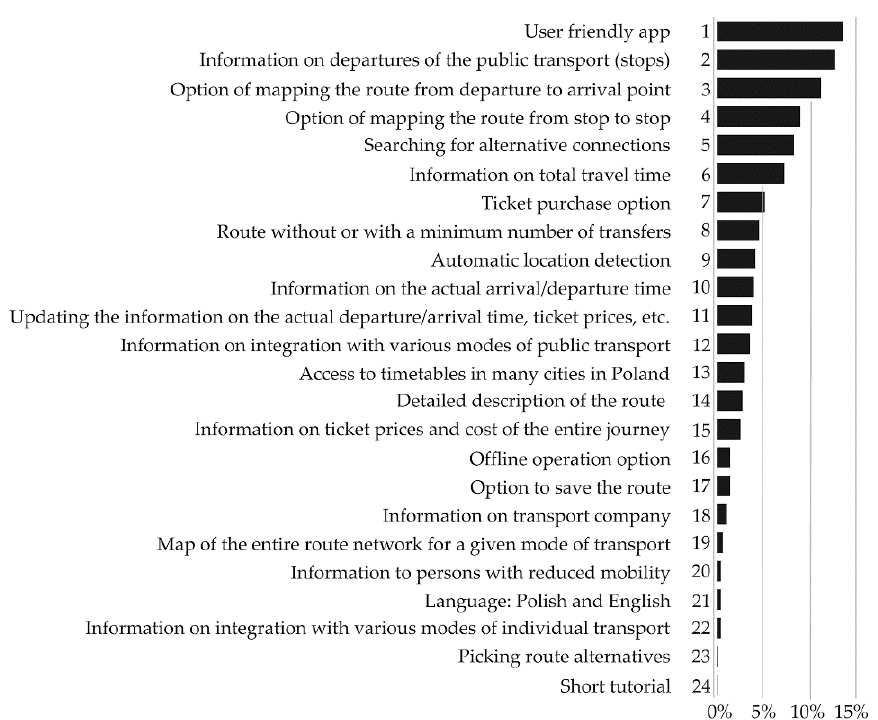
Figure 11. Share of apps used in travels within the Cracow agglomeration based on survey information. Based on the conducted research, it was observed that almost all respondents (97.2%) evaluated the used travel planner positively (good or very good). Only a small percentage of respondents rated the used application as sufficienat (2.2%) or bad (1.1%). Moreover, the respondents pointed out the most important advantages the application should have. The respondents had a choice of 24 elements concerning the travel planner. The most frequently indicated element was its intuitiveness (13.4%) and the information about the departures of the given lines from a specific stop (12.6%). As can be seen in Figure 12, there was a large disproportion in the number of elements that the respondents highlighted.